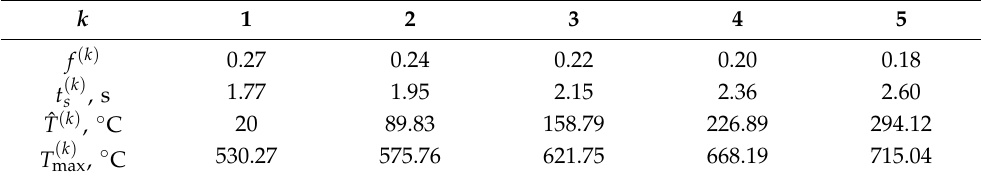
Table 2. Calculation results obtained with constant properties of